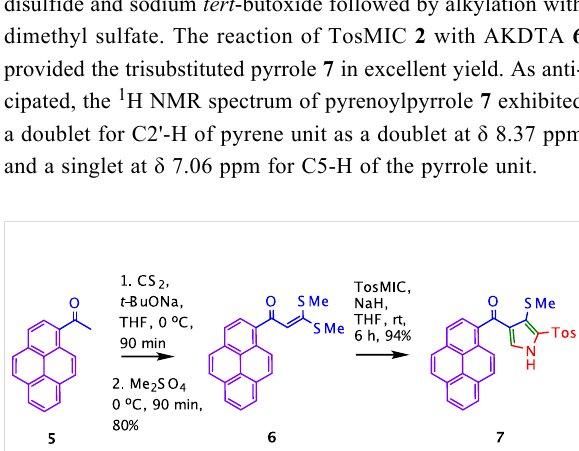
imidazole 4 contaminant by column chromatography. The struc-